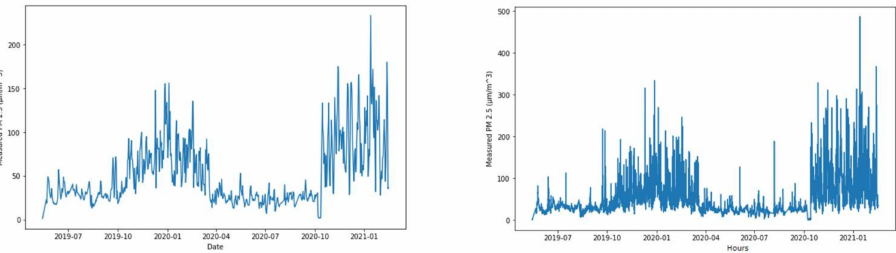
Figure 3. Karachi daily and hourly PM 2.5 concentrations between